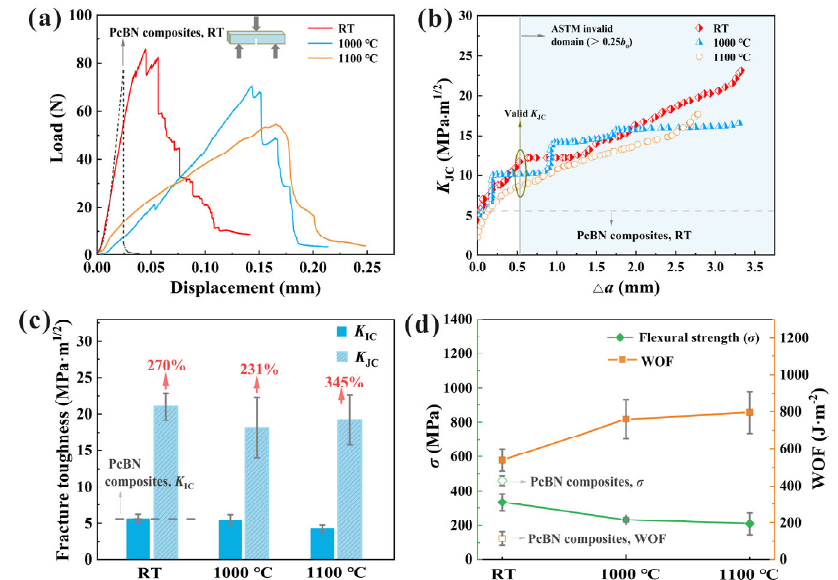
Fig. 5 (a) Load ‒ displacement curves, (b) crack growth R-curves, and (c) fracture toughness and (d) flexural strength and WOF of the PcBN/hBN fibrous monolithic ceramics at different test temperatures, together with homogenous PcBN composites for